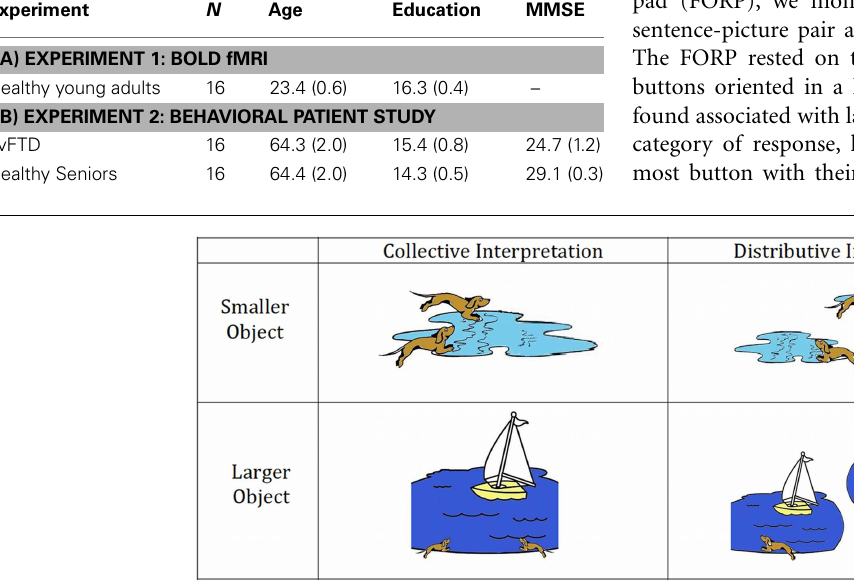
FIGURE 1 | Sample stimulus images for experimental sentence